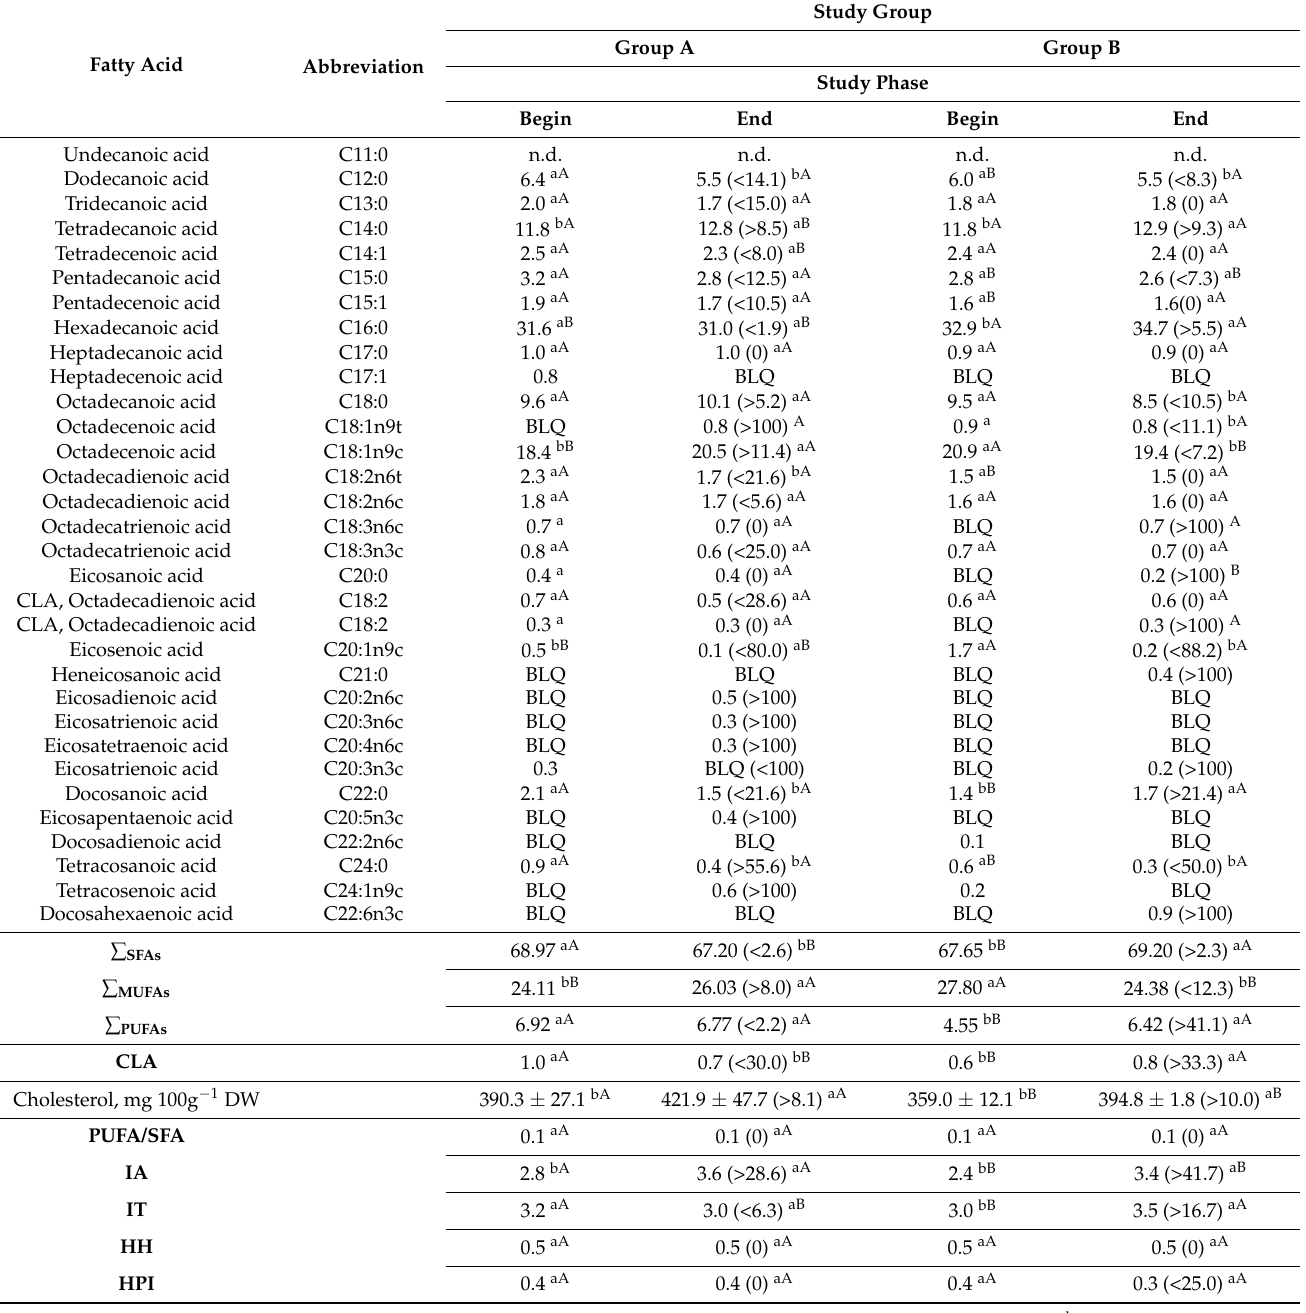
Table 5. Fatty acid profile, cholesterol content, and estimated nutritional indexes of milk lipids in relation to the feeding of lactating dairy cows, %